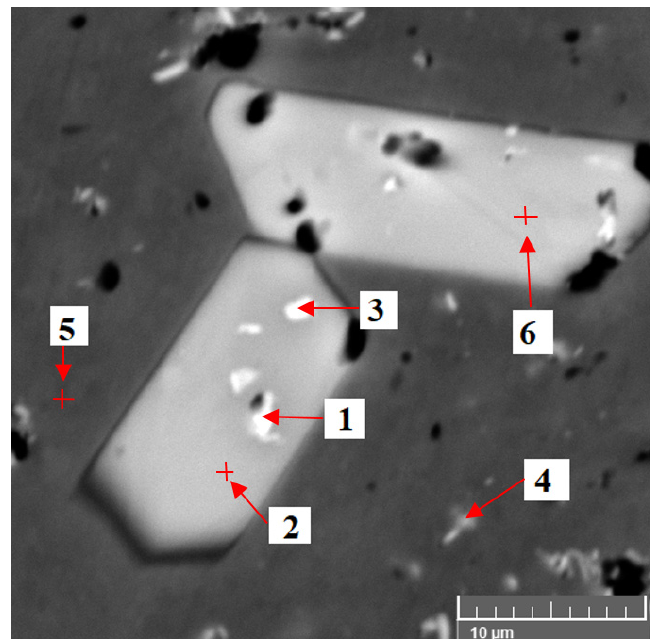
Figure 5. Microstructure of the AlTi3B1 alloy and EDS point analysis. The microstructure of the laser confocal microscope (Figure 4) shows large elongated particles TiAl 3 of size 37 ± 17 µm and fine flaky particles of irregular shape TiB 2 of size 0.5–2 µm. The histogram of the particle size distribution of the TiAl 3 phase is shown in Figure 6. These values were obtained from the image analysis (images from the laser confocal microscope) using analysis application software. More than 200 particles were included in the analysis. In the sample, there is approximately the same amount of particles with a particle diameter of 16 to 61 µm.